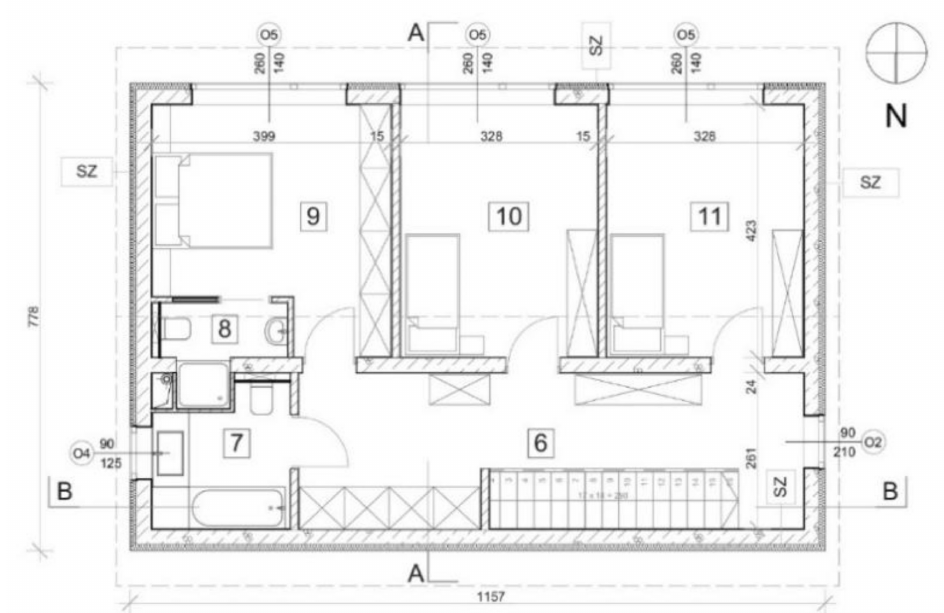
Figure 5. Model B2, B3. Floor plan. Scale of 1:100. Source: own study using ARCHICAD software.